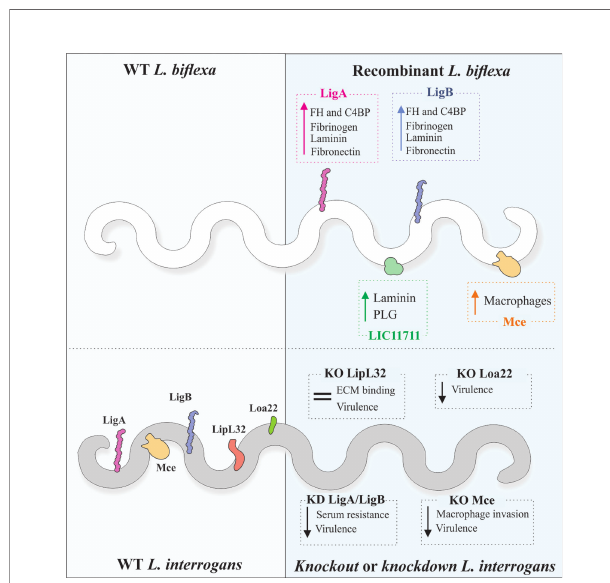
FIGURE 2 | Genetic tools and mutant evaluation of Leptospira. As the saprophytic L. bi fl exa lacks most of the virulence-associated proteins, it is used as a surrogate for the expression of pathogen-speci fi c proteins and gain-of-function phenotype evaluation. Increased binding to ECM and plasma components has been observed in recombinant L. bi fl exa expressing L. interrogans proteins. Contrarily to this strategy, knockout (KO) or knockdown (KD) in the pathogenic L. interrogans has been used to evaluate loss-of- function phenotypes, in comparison to the wild-type strain. Reduced virulence in animal model was observed for KD double LigA/LigB, KO Loa22 and KO Mce mutants. KO of LipL32, the major lipoprotein of pathogenic leptospires, did not alter virulence or ECM